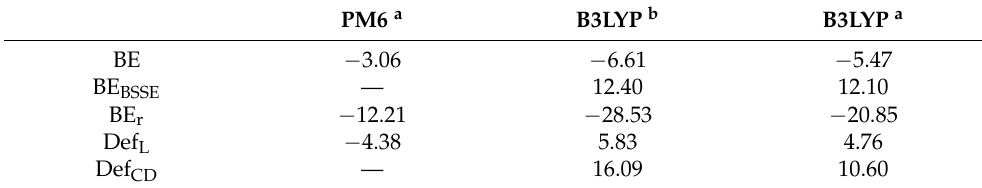
Table 7. Binding energies, BE; corrected values for BSSE, BE BSSE , and binding energies with respect to the deformed structures of the molecules of the complex, BE r (kcal/mol); deformation energies of the losartan and cyclodextrin, Def L and Def CD , at PM6 and B3LYP/6-311G(d,p). All energies are in kcal/mol. PM6 a B3LYP b B3LYP a BE − 3.06 − 6.61 − 5.47 BE BSSE — BE r Def L − 4.38 Def